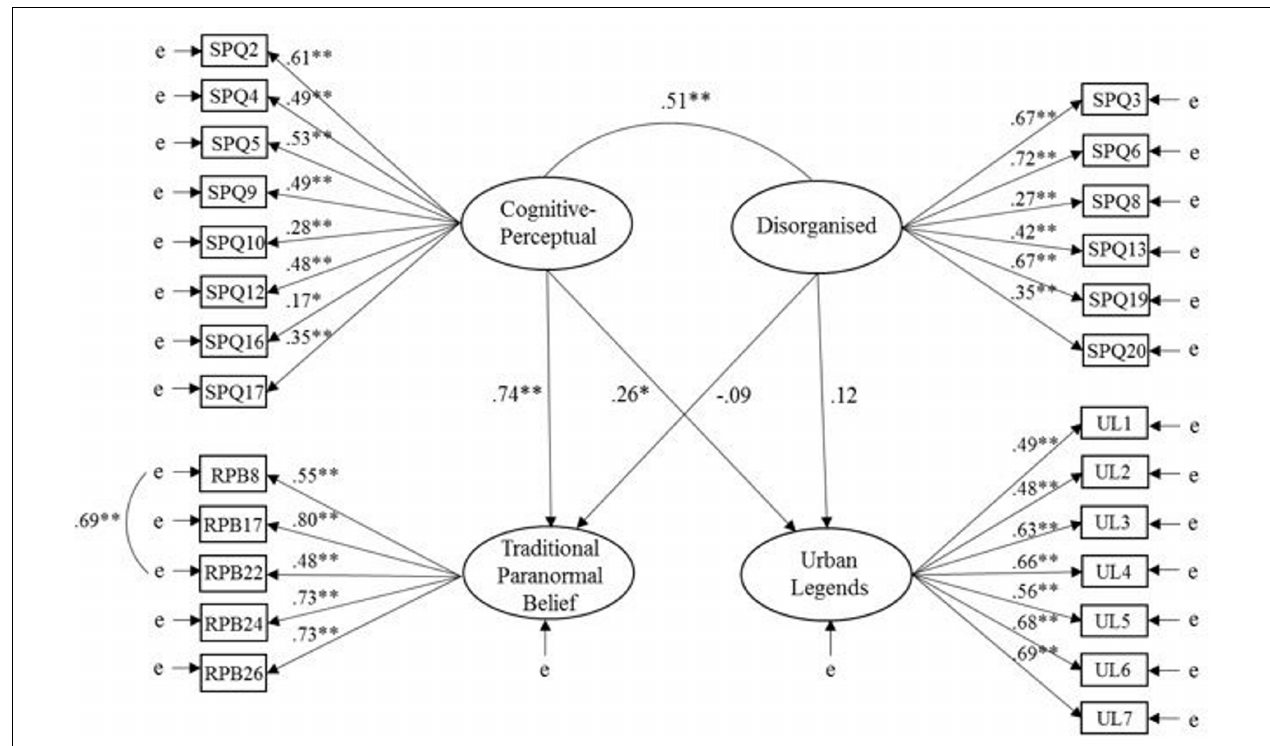
FIGURE 1 | Model 1: relationships of cognitive-perceptual and disorganized schizotypy factors with traditional paranormal belief and urban legends (ULs). Latent variables are represented by ellipses; observed variables are represented by rectangles; error of measurement is indicated by ‘e’; ∗ p < 0.05, ∗∗ p < 0.001.